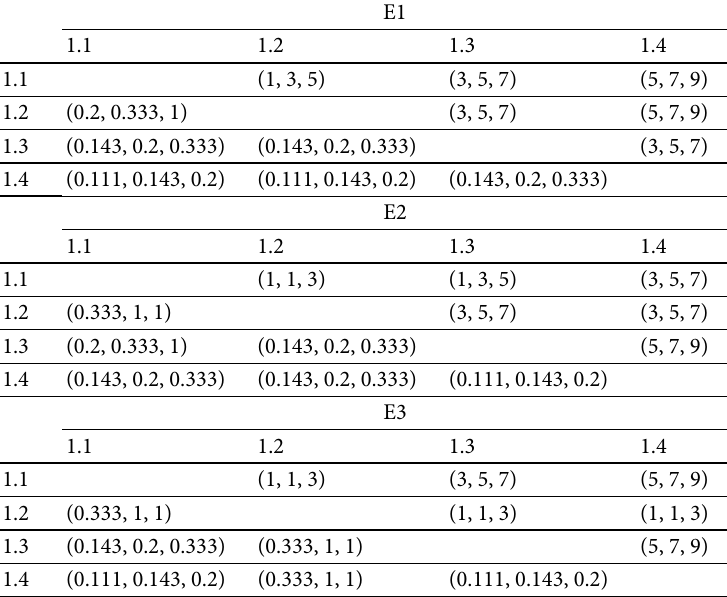
Table 16. Converted fuzzy numbers of experts evaluations for